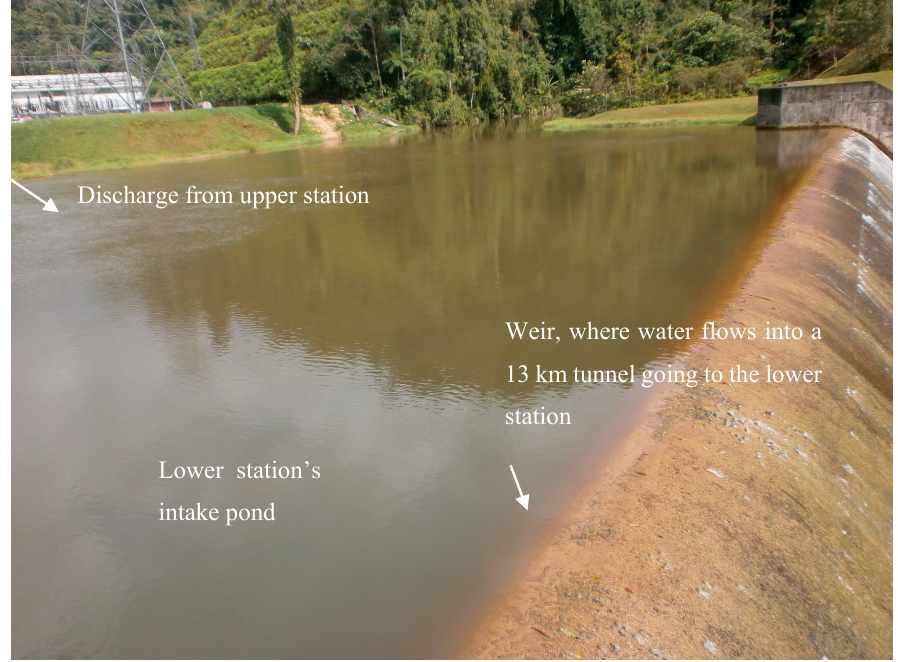
Figure 2. Lower hydroelectric intake pond with spillage.